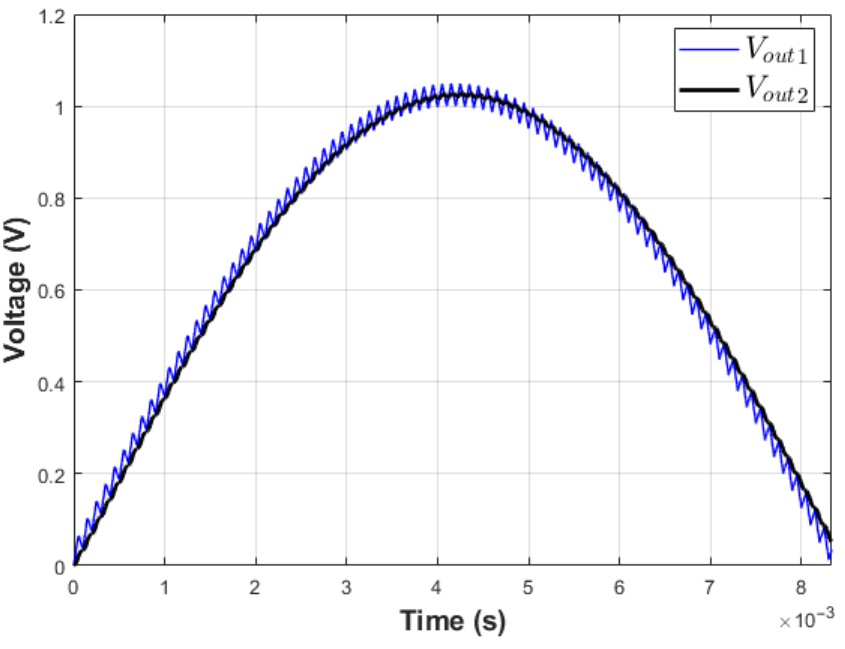
Figure 9. Simulation of the RC anti-aliasing filter.